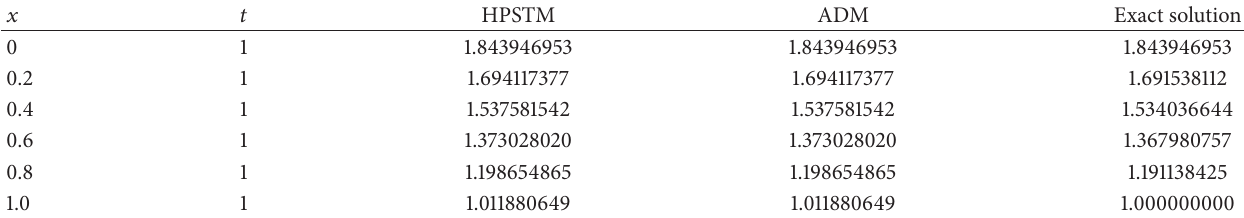
Table 1: Comparison study between HPSTM, ADM, and the exact solution, when 𝛼 = 1 and for constant values of 𝑎 = 4 and 𝑏 = 1